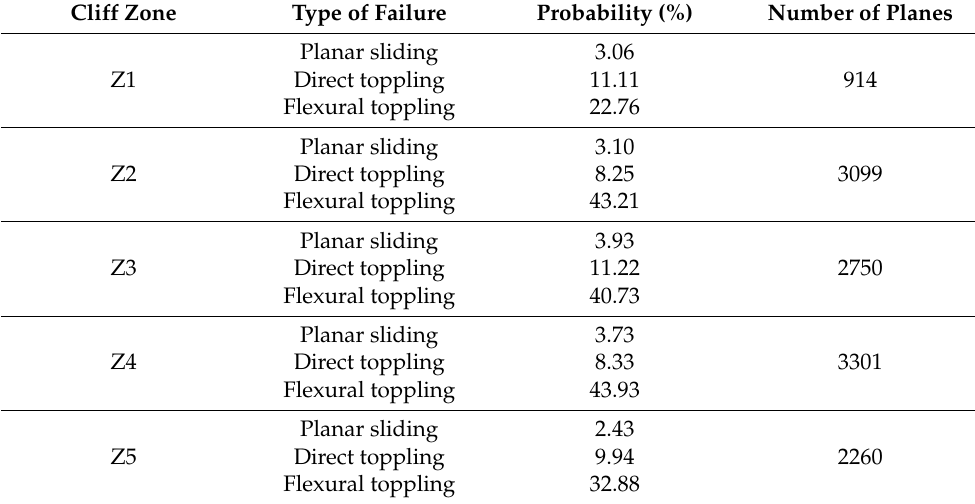
Table 5. Summary of conducted kinematic analyses according to cliff zones. Probability is expressed as the ratio of number of planes (or combination of planes) meeting the conditions for a failure related to the number of all planes (or combination of planes). All planes determined in a zone are used in verification of all kinematic